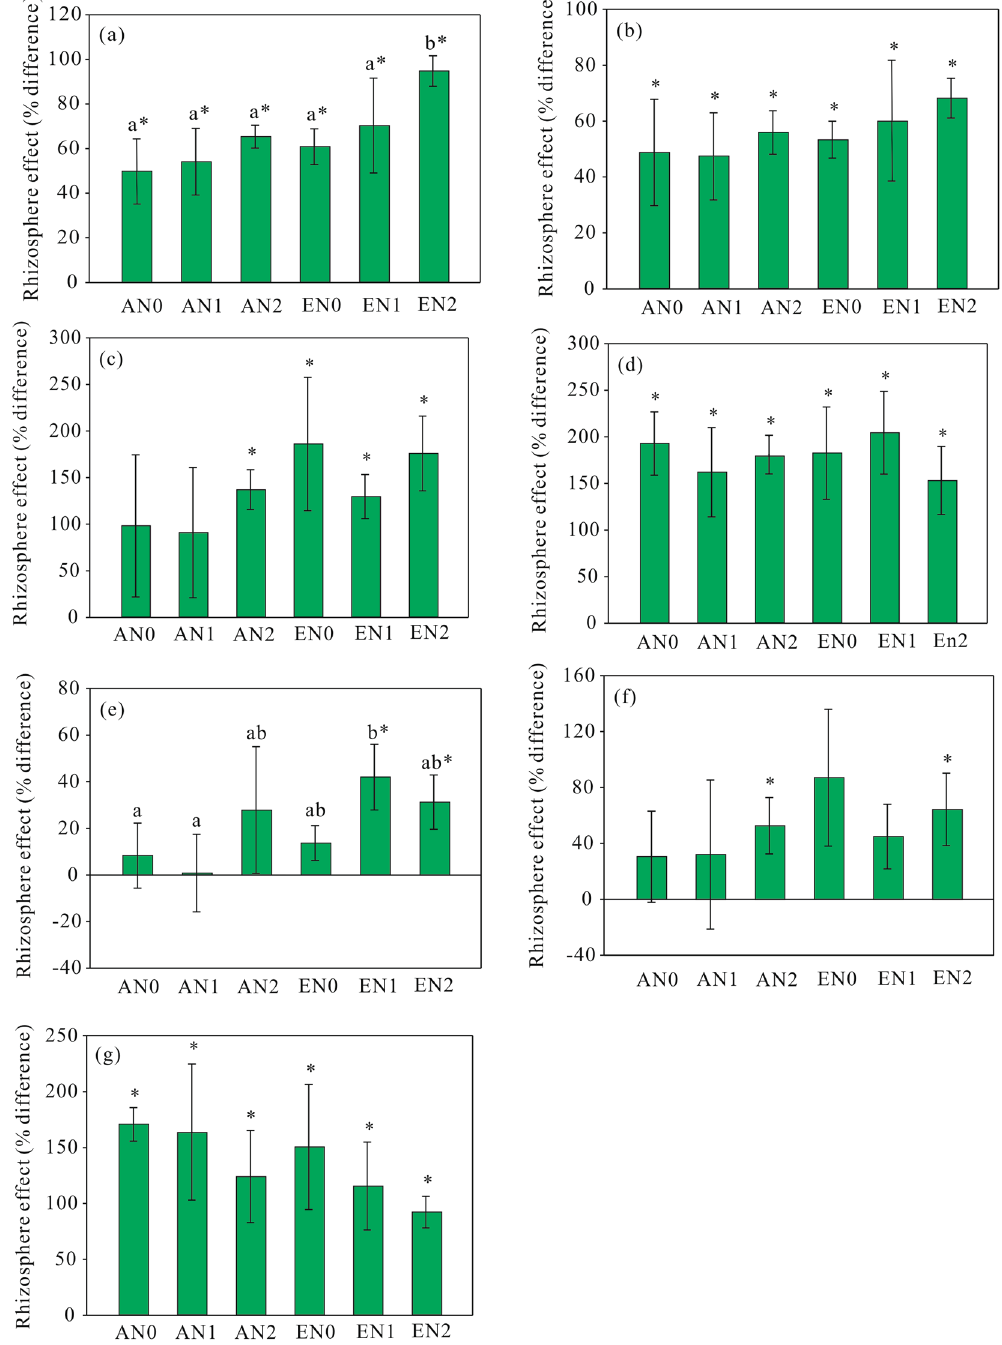
Figure 5. Rhizospheric effects for total PLFA ( a ), bacterial PLFA ( b ), fungal PLFA ( c ), G + PLFA ( d ), G − PLFA ( e ), fungal/bacterial PLFA ( f ), and G + /G − PLFA ( g ) in the treatments. * Above each bar indicates significant difference between the rhizosphere and bulk soil. Different lowercase letters indicate significant differences in rhizospheric effects between treatments. AN0, ambient CO 2 and no N added; AN1 ambient CO 2 and N supply at a rate of 2.5 g N m − 2 y − 1 ; AN2, ambient CO 2 and N supply at a rate of 5 g N m − 2 y − 1 ; EN0, elevated CO 2 and no N added; EN1, elevated CO 2 and N supply at a rate of 2.5 g N m − 2 y − 1 ; EN2, elevated CO 2 and N supply at a rate of 5 g N m − 2 y − 1